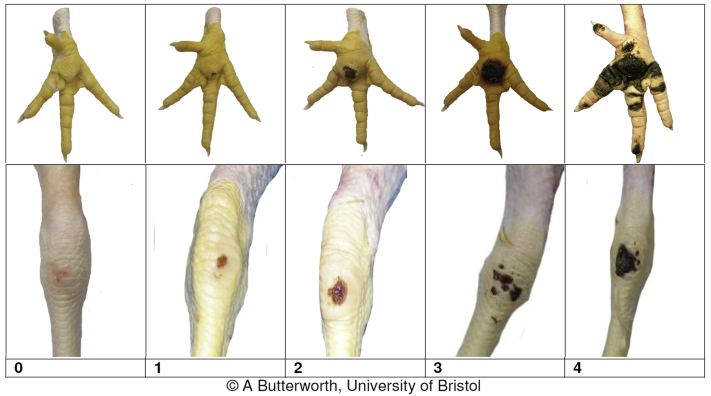
Visual scales for scoring foot pad dermatitis and hock burn (Welfare Quality, 2009).